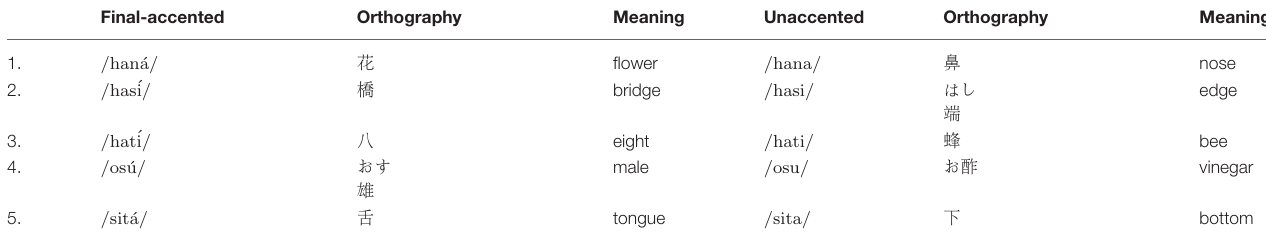
TABLE 1 | Test words used in the